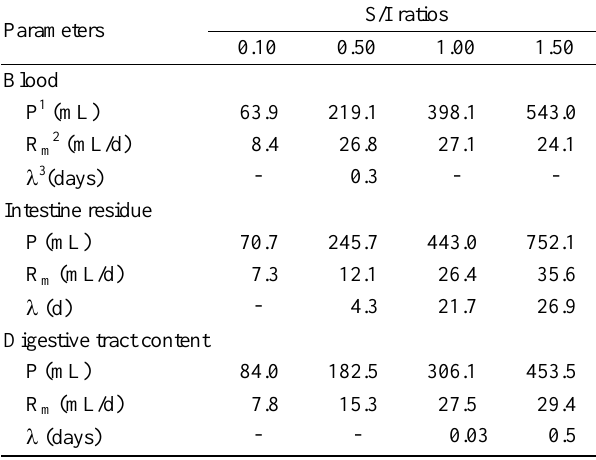
Table 4. Parameters obtained by model optimization of cumulative methane production from piggery slaughterhouse wastes at different substrate to inoculum (S/I) ratios